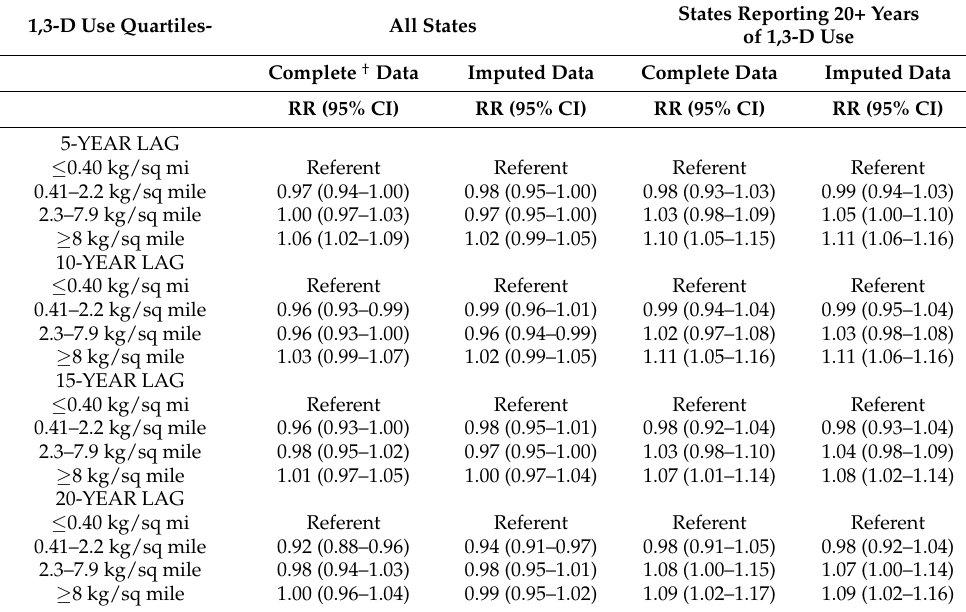
Table 3. Rate ratios * (RRs) and associated 95% confidence intervals (CIs) for the association between 1,3 dichloropropene (1,3-D) use and pancreatic cancer-related mortality. 1,3-D Use Quartiles-